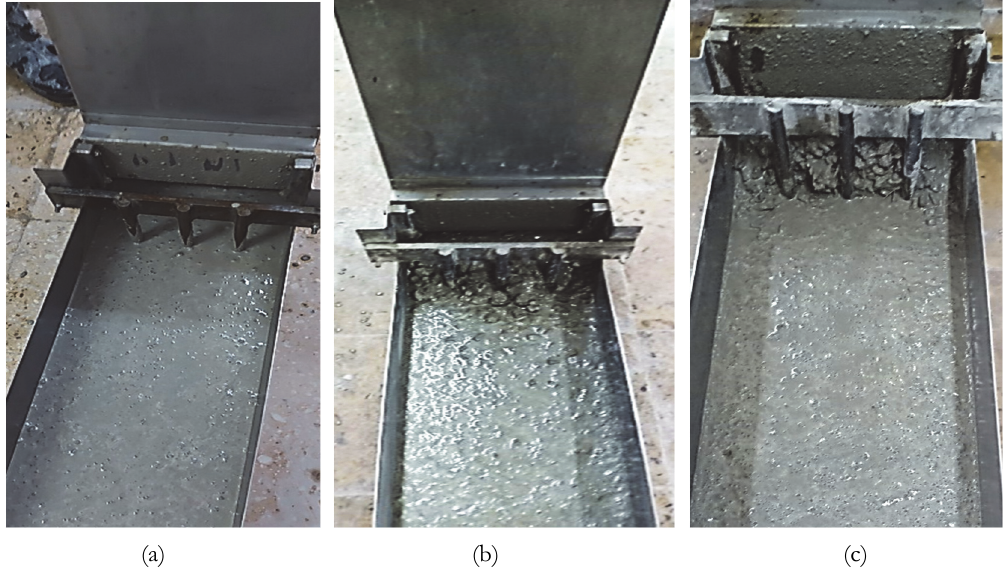
Figure 15: L-Box test of concretes: (a) RSCC, (b) PPSCC12 and (c) DPSCC12.